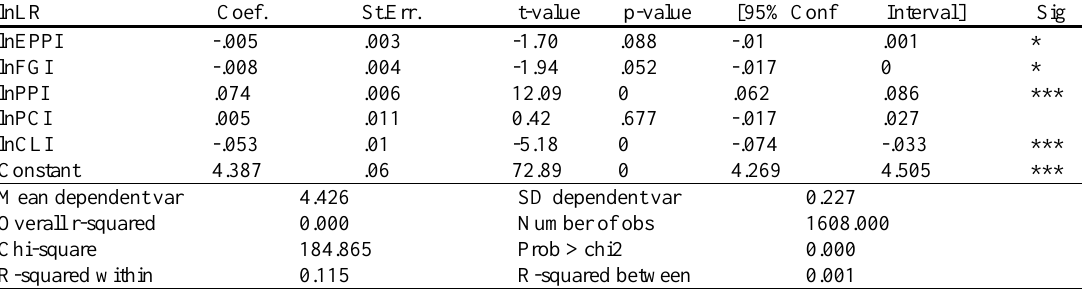
Table 3: Pooled Ordinary Least Square (POLS)